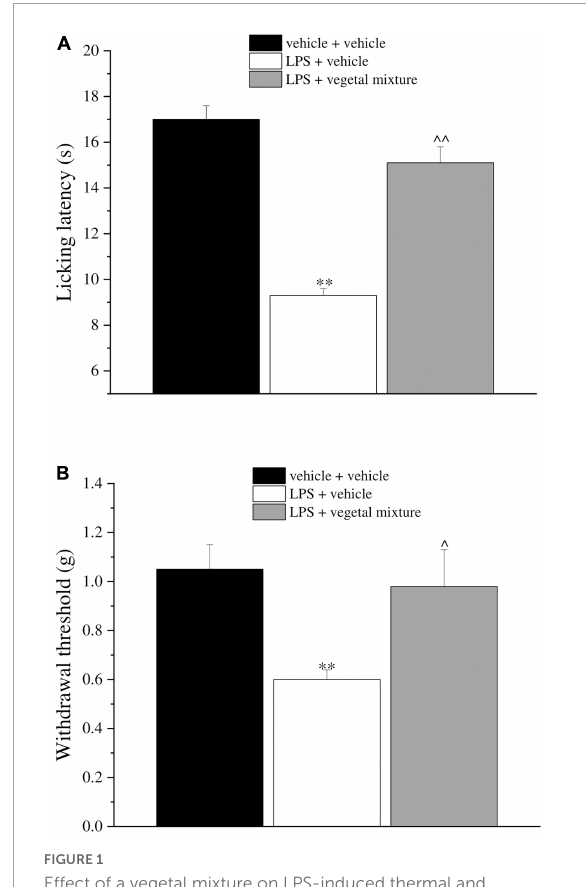
FIGURE1 Effect of a vegetal mixture on LPS-induced thermal and mechanical allodynia. LPS (1 mg kg - 1 ) was intraperitoneally injected on days 1, 3, 5, and 8. The vegetal mixture was composed of Zingiber officinale (150 mg kg - 1 ), Echinacea purpurea (20 mg kg - 1 ), and Centella asiatica (200 mg kg - 1 ), suspended in 1% carboxymethylcellulose sodium salt (CMC) and orally administered daily starting from day 1 till the end of the experiment. Control animals were treated with vehicles. On day 9 and 24 h after the last administration of the vegetal mixture, (A) thermal and (B) mechanical allodynia was assessed by the Cold plate and von Frey tests, respectively. Data are expressed as the mean ± SEM of values from eight mice analyzed in two different experimental sets. ∗∗ p < 0.01 vs. vehicle + vehicle; ∧ p < 0.05 and ∧∧ p < 0.01 vs. LPS +